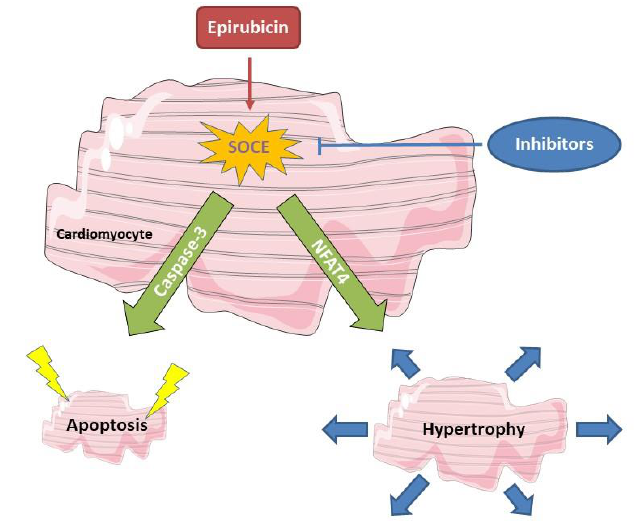
Figure 7. Working model. Acute treatment of EPI enhanced SOCE, triggering NFAT4-mediated hypertrophy and caspase3-mediated apoptosis in cardiomyocytes. Both the EPI-induced apoptosis and hypertrophy can be inhibited by blocking SOCE.